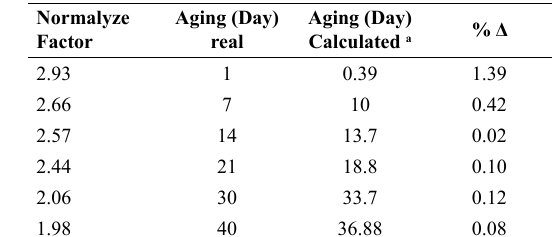
Figure 3. Aging time vs. ∆Tmax (◦C)